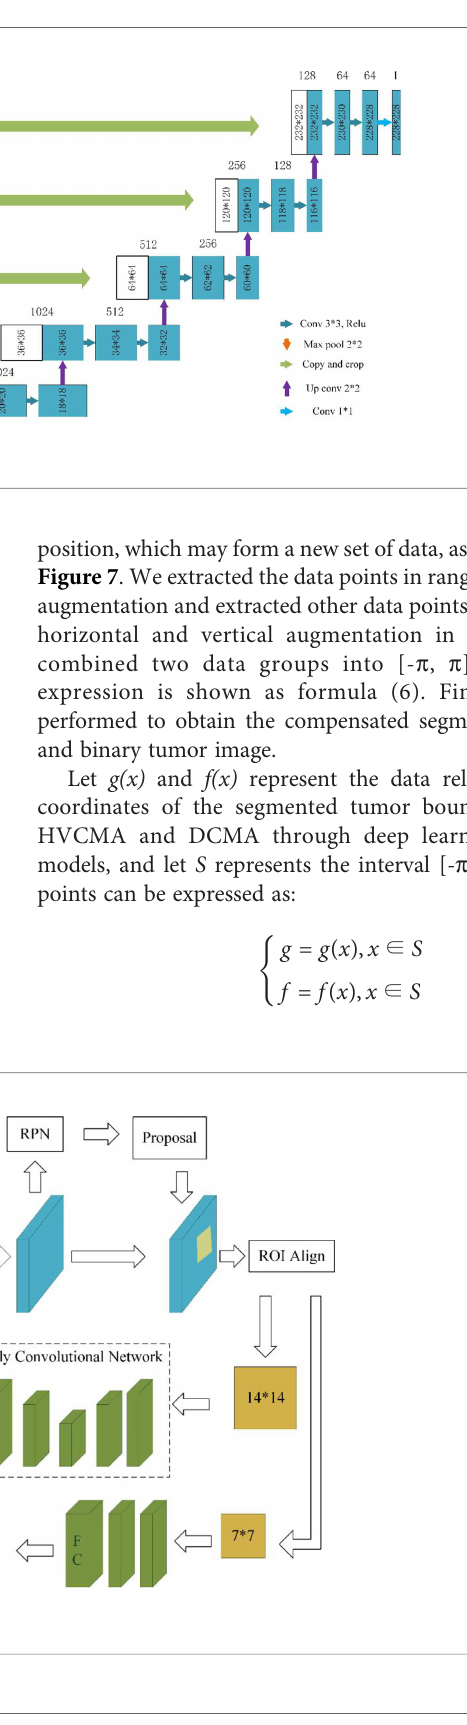
FIGURE 5 | Mask-RCNN network architecture.